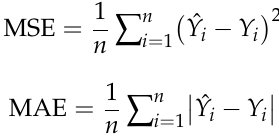
Figure 7. Visualized evaluation functions for each generation: LSTM model. MSE and Mean Absolute Error (MAE) performance indicators were used to compare the performance of the optimal hyper-parameters in this paper. The formulas for MSE and MAE are as follows. The MSE and MAE performance indicators are the most popular error functions used to optimize deep learning